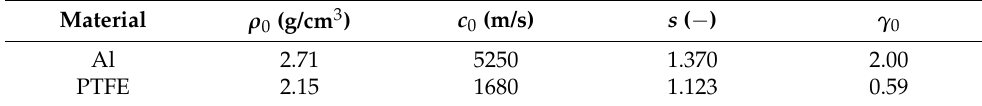
Table 1. EOS parameters of the materials.